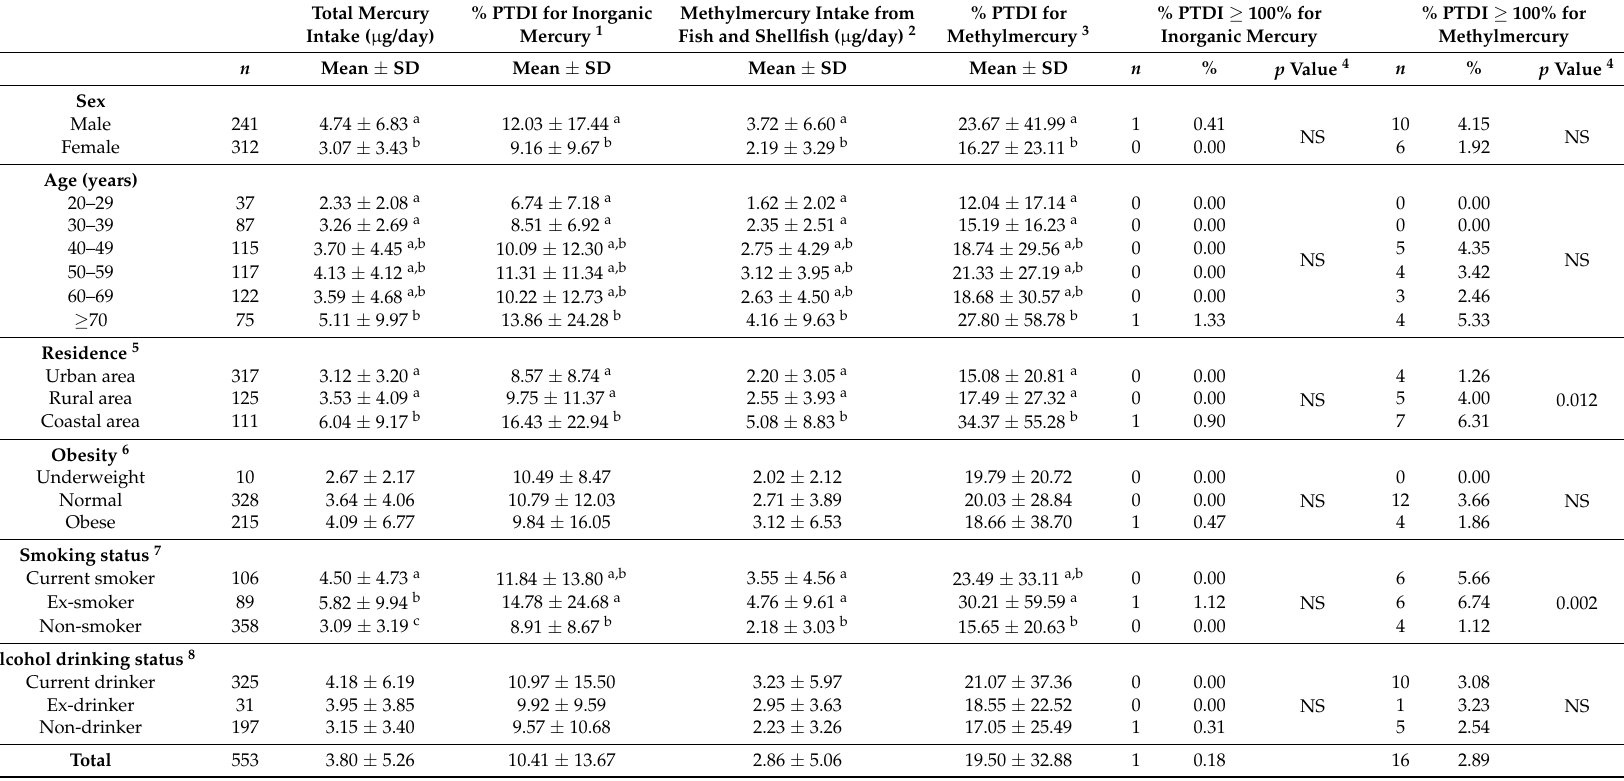
Table 2. Average daily intake of total mercury, methylmercury and percent